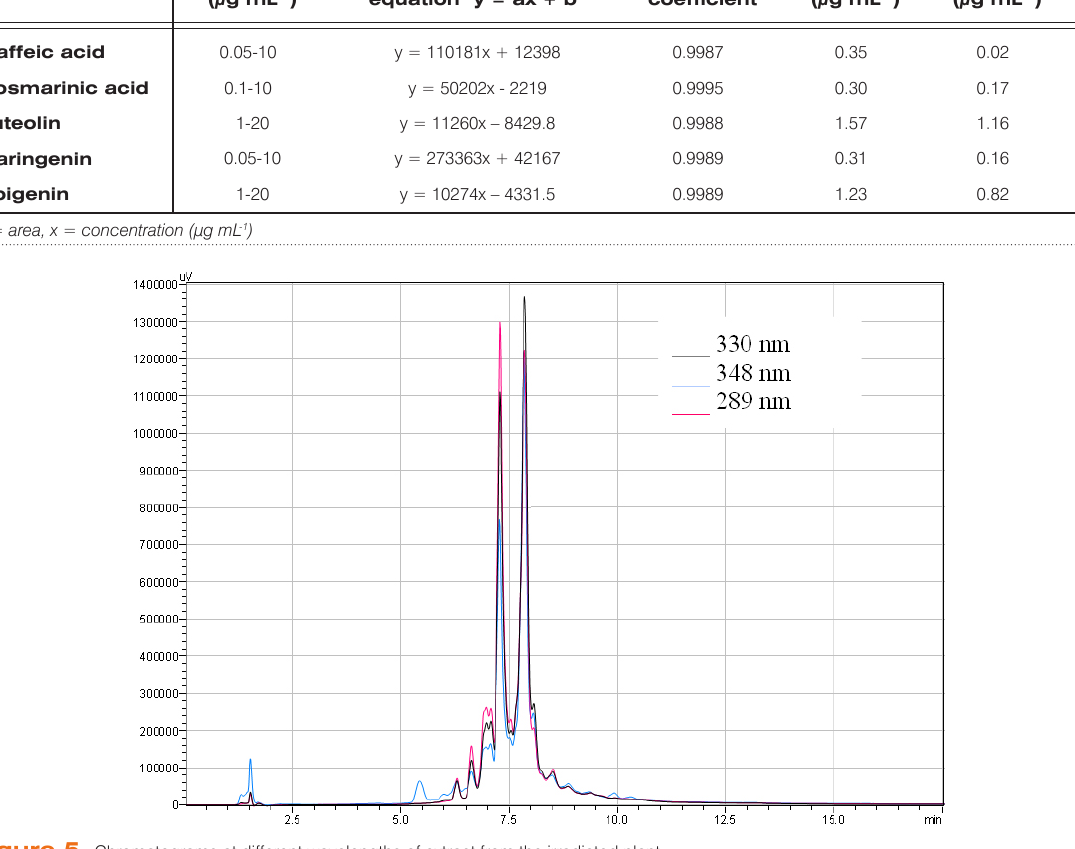
Figure 5. Chromatograms at different wavelengths of extract from the irradiated plant.